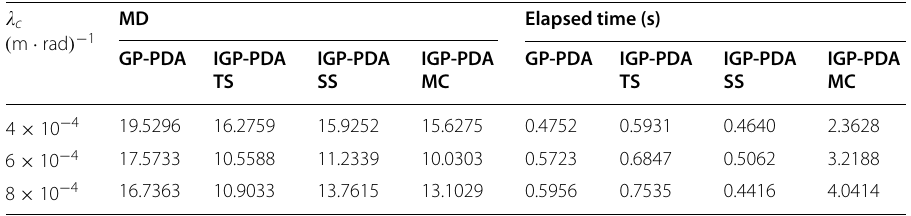
Table 10 Effect of clutter density on contour estimates MD and elapsed time in the second scenario